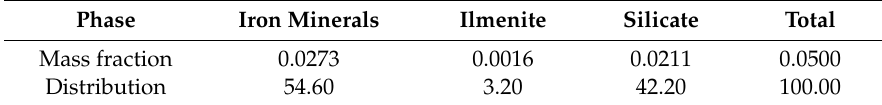
Table 5. Chemical phase analysis of vanadium in raw sample (wt